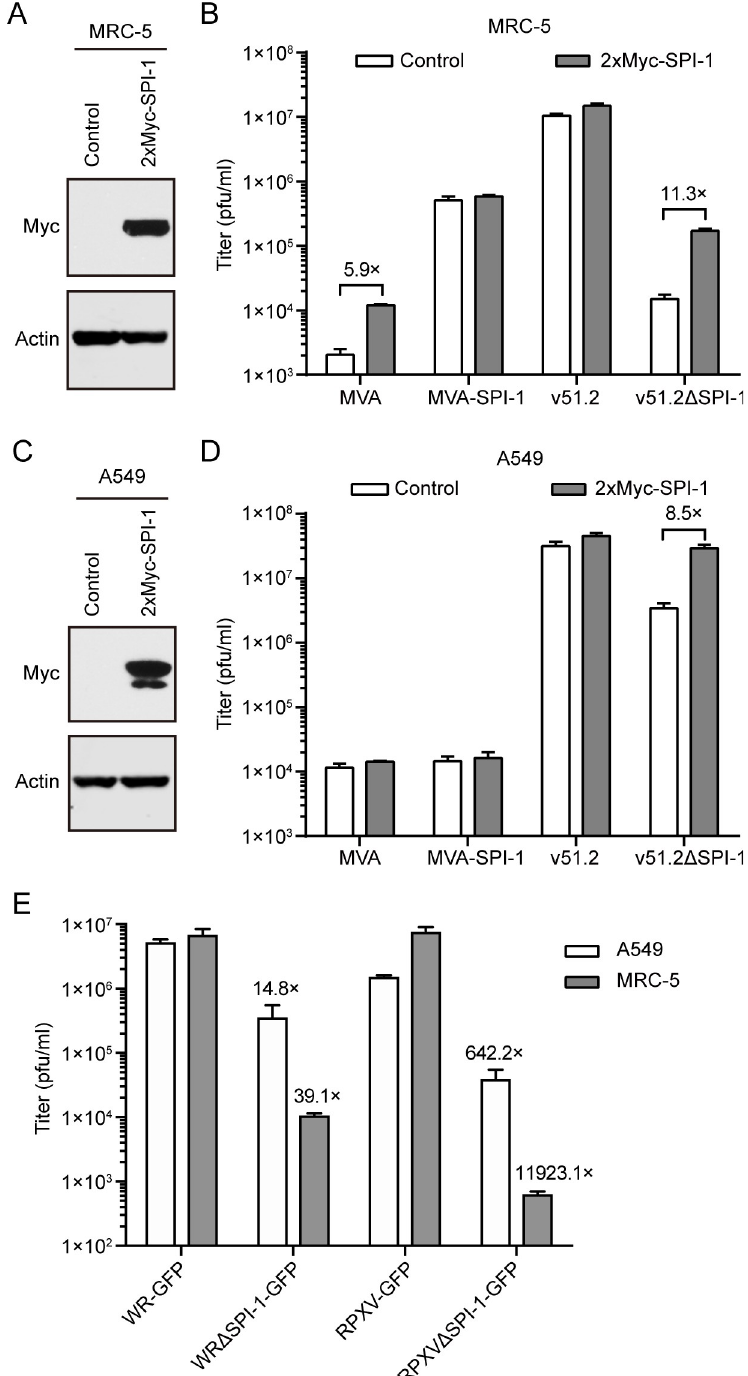
Fig 5. Replication of recombinant MVA, VACV WR, and RPXV in parental or SPI-1-expressing MRC-5 and A549 cells. ( A, C ) Expression of SPI-1. MRC-5 (A) and A549 (C) cells were infected with retroviruses that express 2xMyc- SPI-1 or control retroviruses and selected by antibiotic resistance. Western blots with antibody to the Myc tag are shown. The minor Myc band in panel C is assumed to be due to degradation. ( B, D ) Replication of MVA, MVA-SPI-1, v51.2, v51.2 Δ SPI-1 at MOI of 0.01 in control and SPI-1 expressing MRC-5 (B) and A549 (D) cells. ( E ) A549 and MRC- 5 cells were infected at a MOI of 0.01 in triplicate with VACV WR expressing GFP without (WR-GFP) or with a deletion of SPI-1 (WR Δ SPI-1-GFP) and RPXV expressing GFP without (RPXV-GFP) or with a deletion of